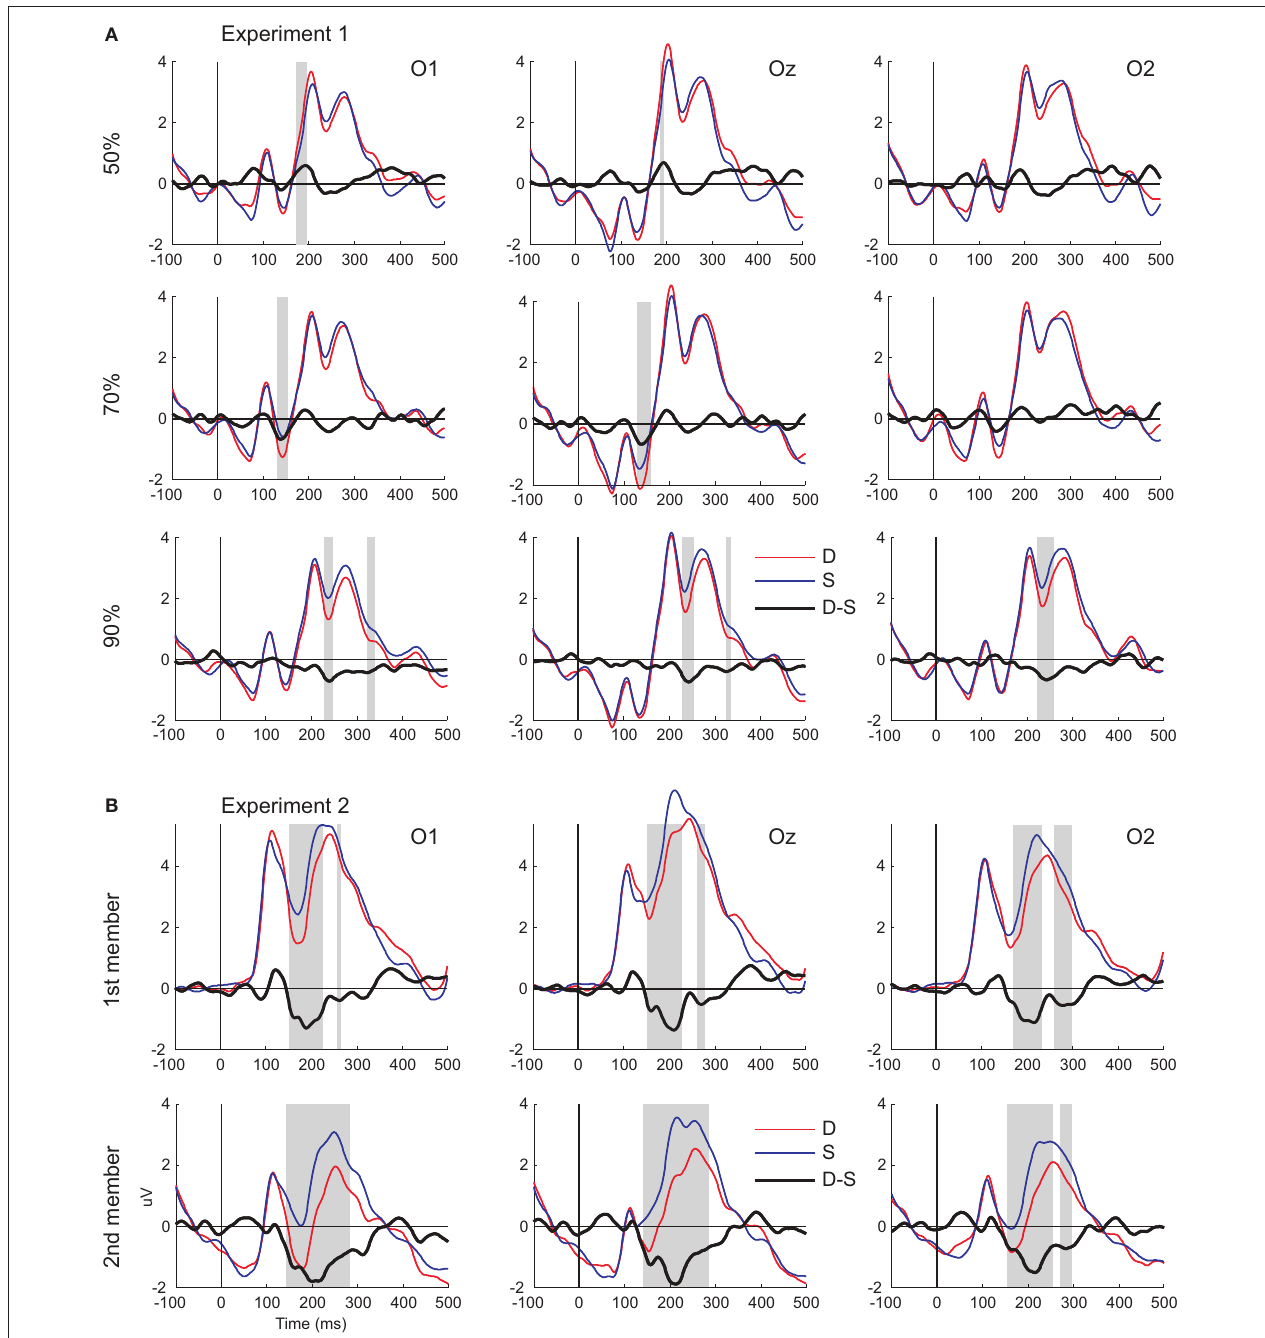
Figure 2 | Visual mismatch negativity waveforms and erP responses to standard and deviant stimuli. (A) Responses from Experiment 1 (upper panel). (B) Responses from Experiment 2 (lower panel). Shaded areas mark the intervals where significant differences were found between deviant and standards (indicated by point-by-point